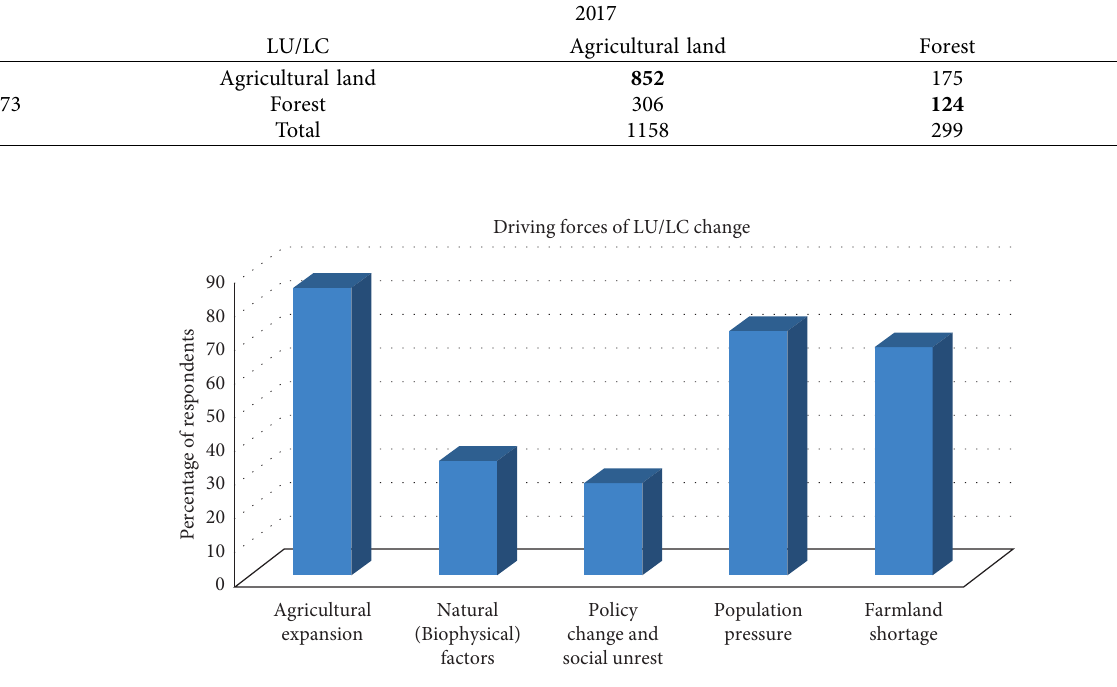
Figure 5: Driving forces of land use change based on community